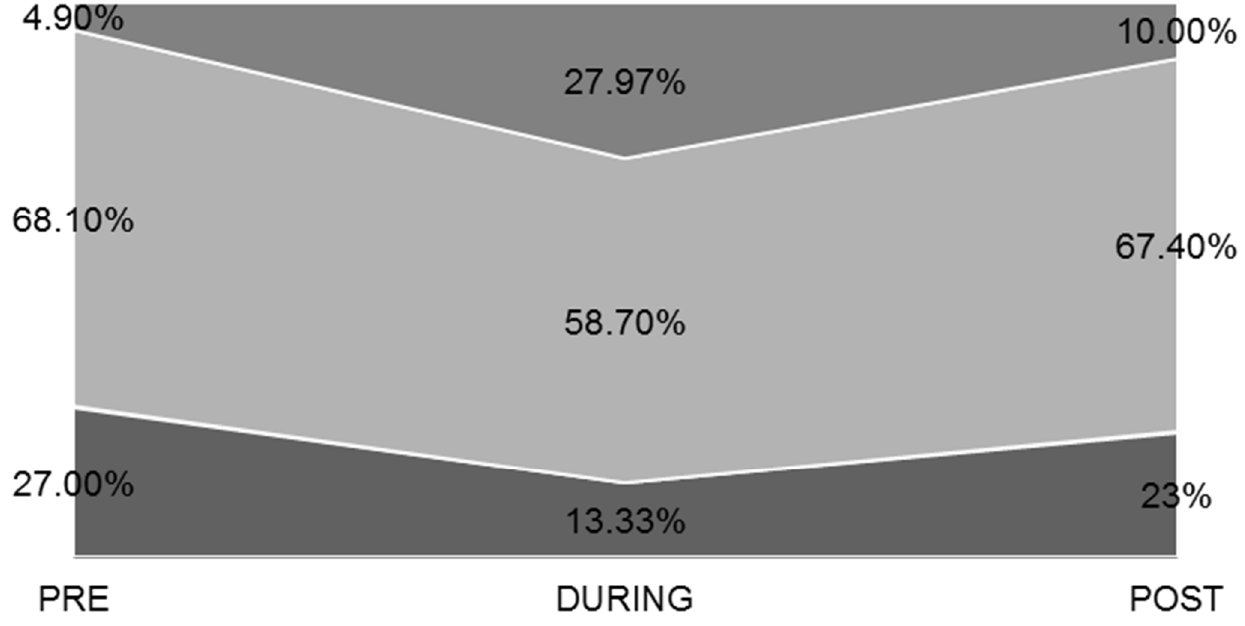
Figure 2. Hours of